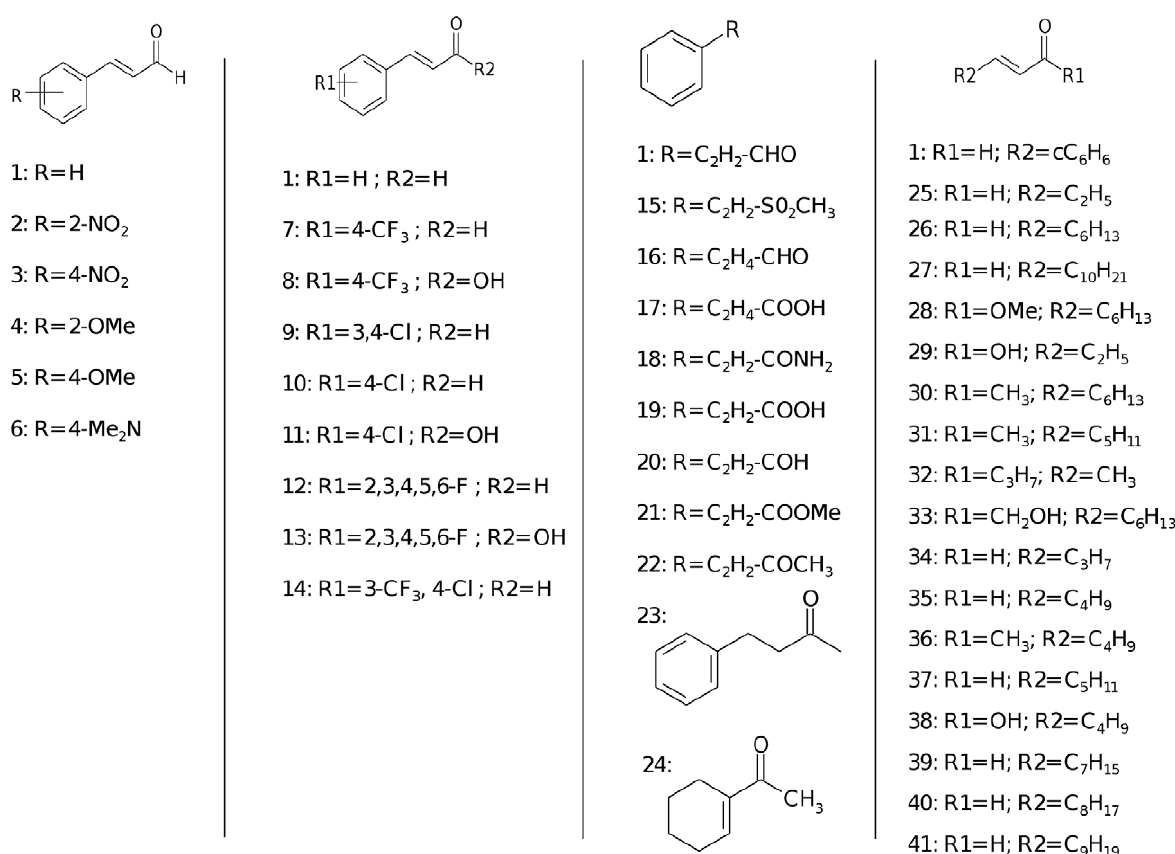
Figure 1. Cinnamaldehyde and cinnamaldehyde analogs used in the present study.